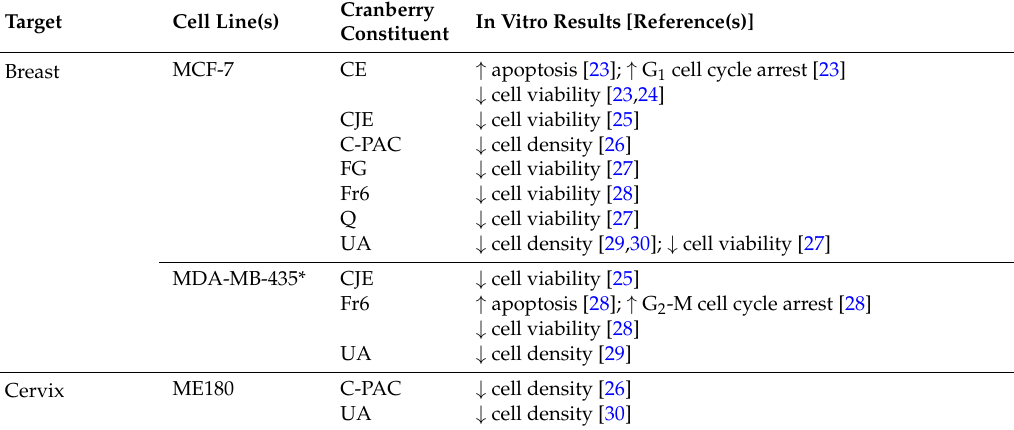
Table 1. Summary of preclinical in vitro evaluations of cranberries or cranberry derived constituents as cancer